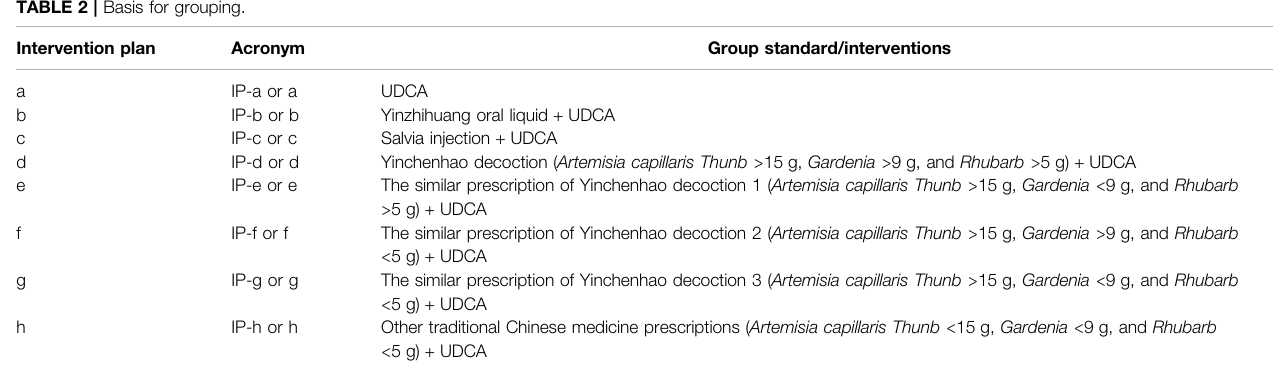
TABLE 2 | Basis for